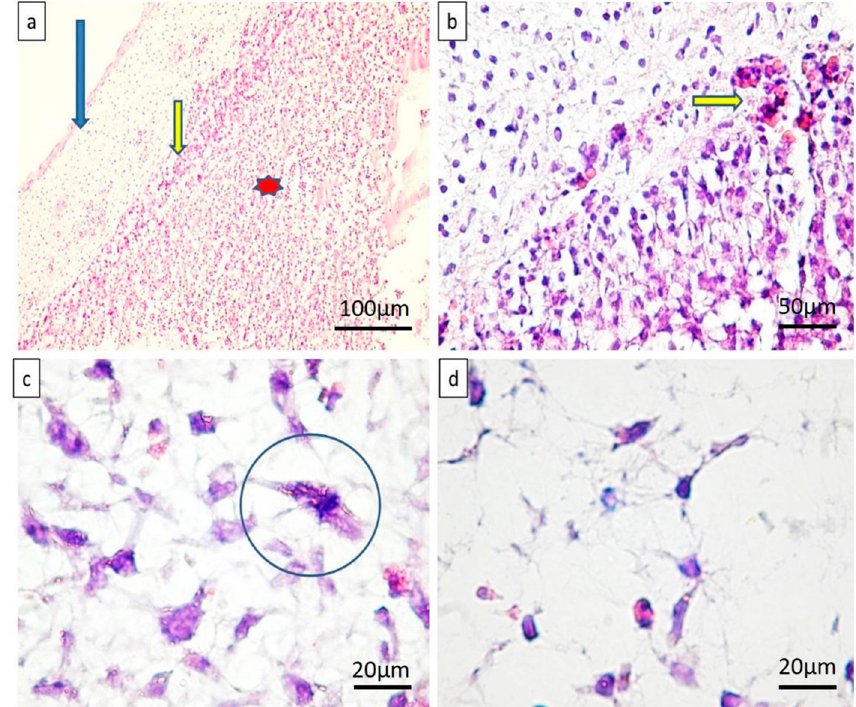
Figure 2. Microscopic view of CAM with a BH implant. There is an obvious integration of the BH implant inside CAM mesenchyme, with a clear stratification of the implant. The BH complex had a stratified appearance ( a ) below the CAM (blue arrow), the outer layer of BH (yellow arrow), and the internal area of BH (marked by red star). A well defined vascular network of small blood vessels penetrating the implant was observed ( b ) (yellow arrow). Stromal densification ( c ) compared to normal CAM ( d ). Mitotic activity of stromal mesenchymal cells was often seen amongst cells of CAM chorion, as marked in ( c ) (blue circle).